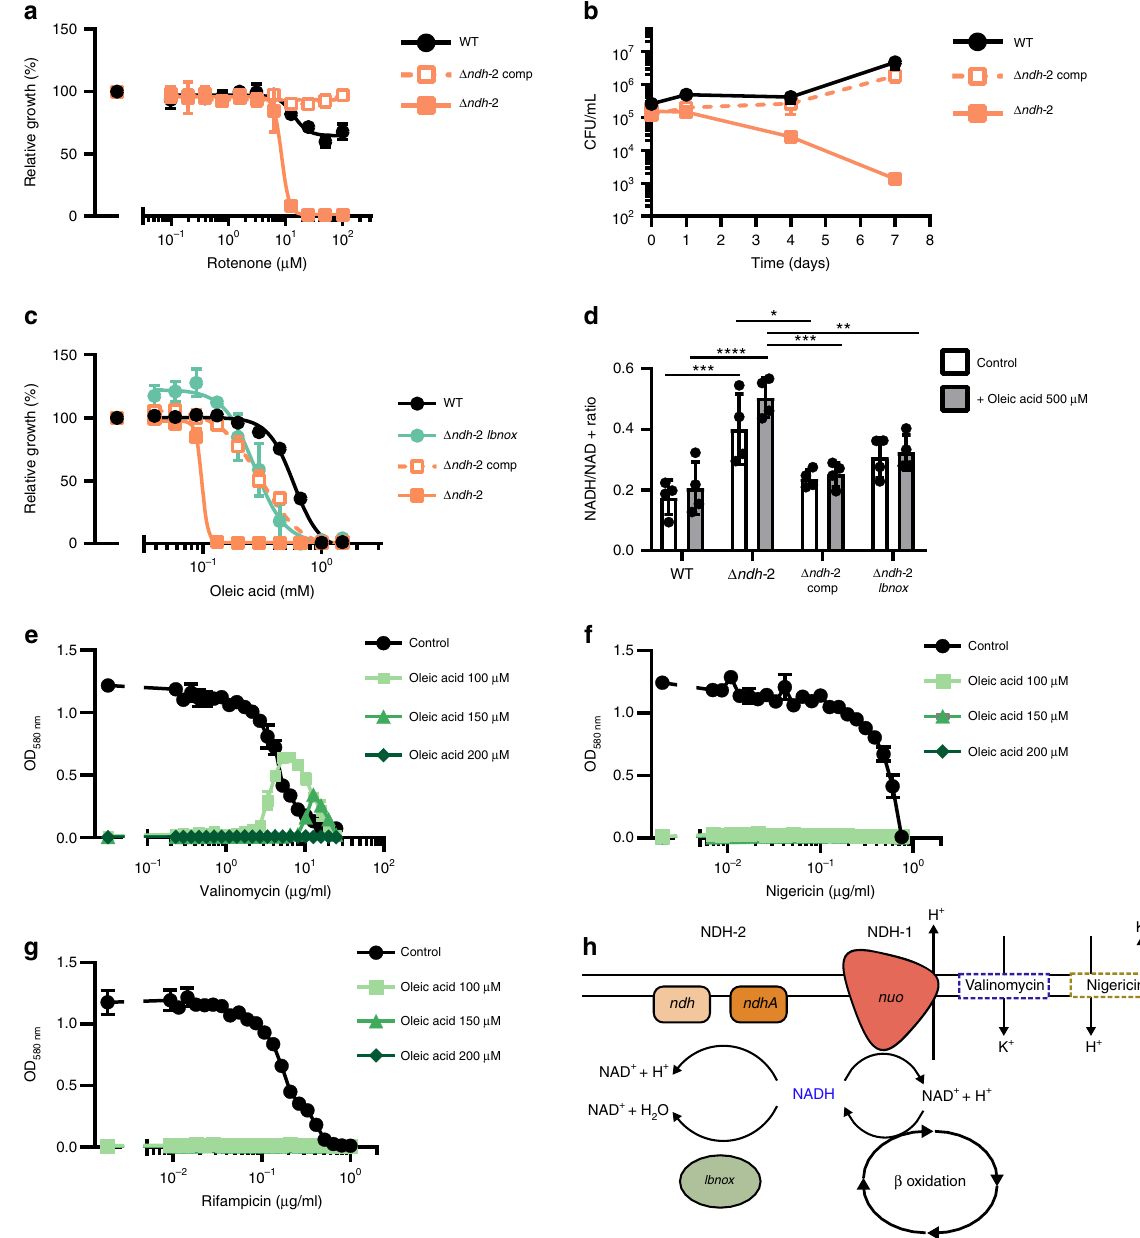
Fig. 5 NDH-2 is required for redox homeostasis and counteracts inhibition of NDH-1. a Impact of rotenone on growth. b Survival in fatty-acid-free Sauton ’ s minimal medium supplemented with 50 μ g/mL rotenone. c Impact of oleic acid on growth. ( d ) NADH/NAD + intracellular ratio after 6 h in modi fi ed Sauton ’ s minimal medium supplemented with DMSO (1%, control), or oleic acid (500 μ M). Impact of valinomycin ( e ), nigericin ( f ), and rifampicin ( g ) on growth in modi fi ed Sauton ’ s minimal medium supplemented with DMSO (1%; control), or oleic acid at different concentrations (100 μ M, 150 μ M, and 200 μ M). h Proposed mechanism of NDH-2 essentiality in the presence of fatty acids. Data are averages of three data points and representative of at least two independent experiments. Error bars correspond to standard deviation. “ Comp ” stands for complemented. Statistical signi fi cance was assessed by one- way ANOVA followed by post hoc test (Tukey test; GraphPad Prism). * P < 0.05; ** P < 0.01; *** P < 0.001; **** P < 0.0001. Source data are provided as a